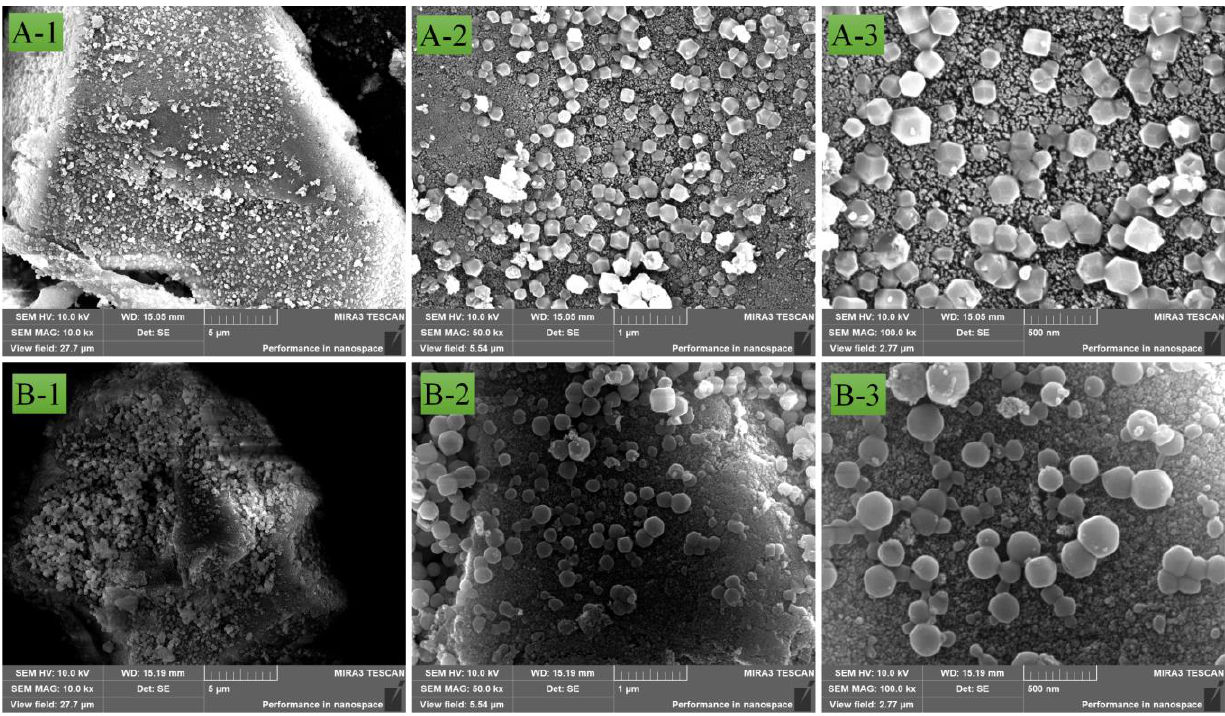
Figure 2. SEM of Sil@ZIF8 ( A-1 – A-3 ) and one of Sil@ZIF8@IL-IL ( B-1 – B-3 ) at different scales. The FTIR of materials are shown in Figure S2. Two peaks at 689.0 cm − 1 and 758.8 cm − 1 are shown on ZIF8, and one peak at 805.5 cm − 1 was shown on Sil. On Sil@ZIF8, three peaks appeared at the same positions. This phenomenon also applied to the peaks at 1309.1 cm −